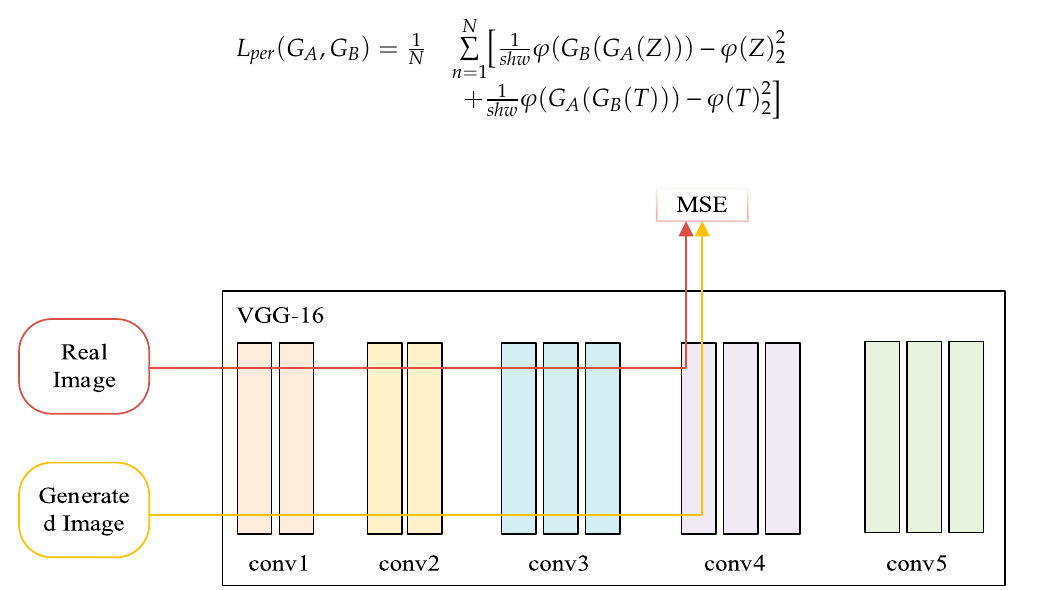
Figure 5. The calculation process of perceptual loss.